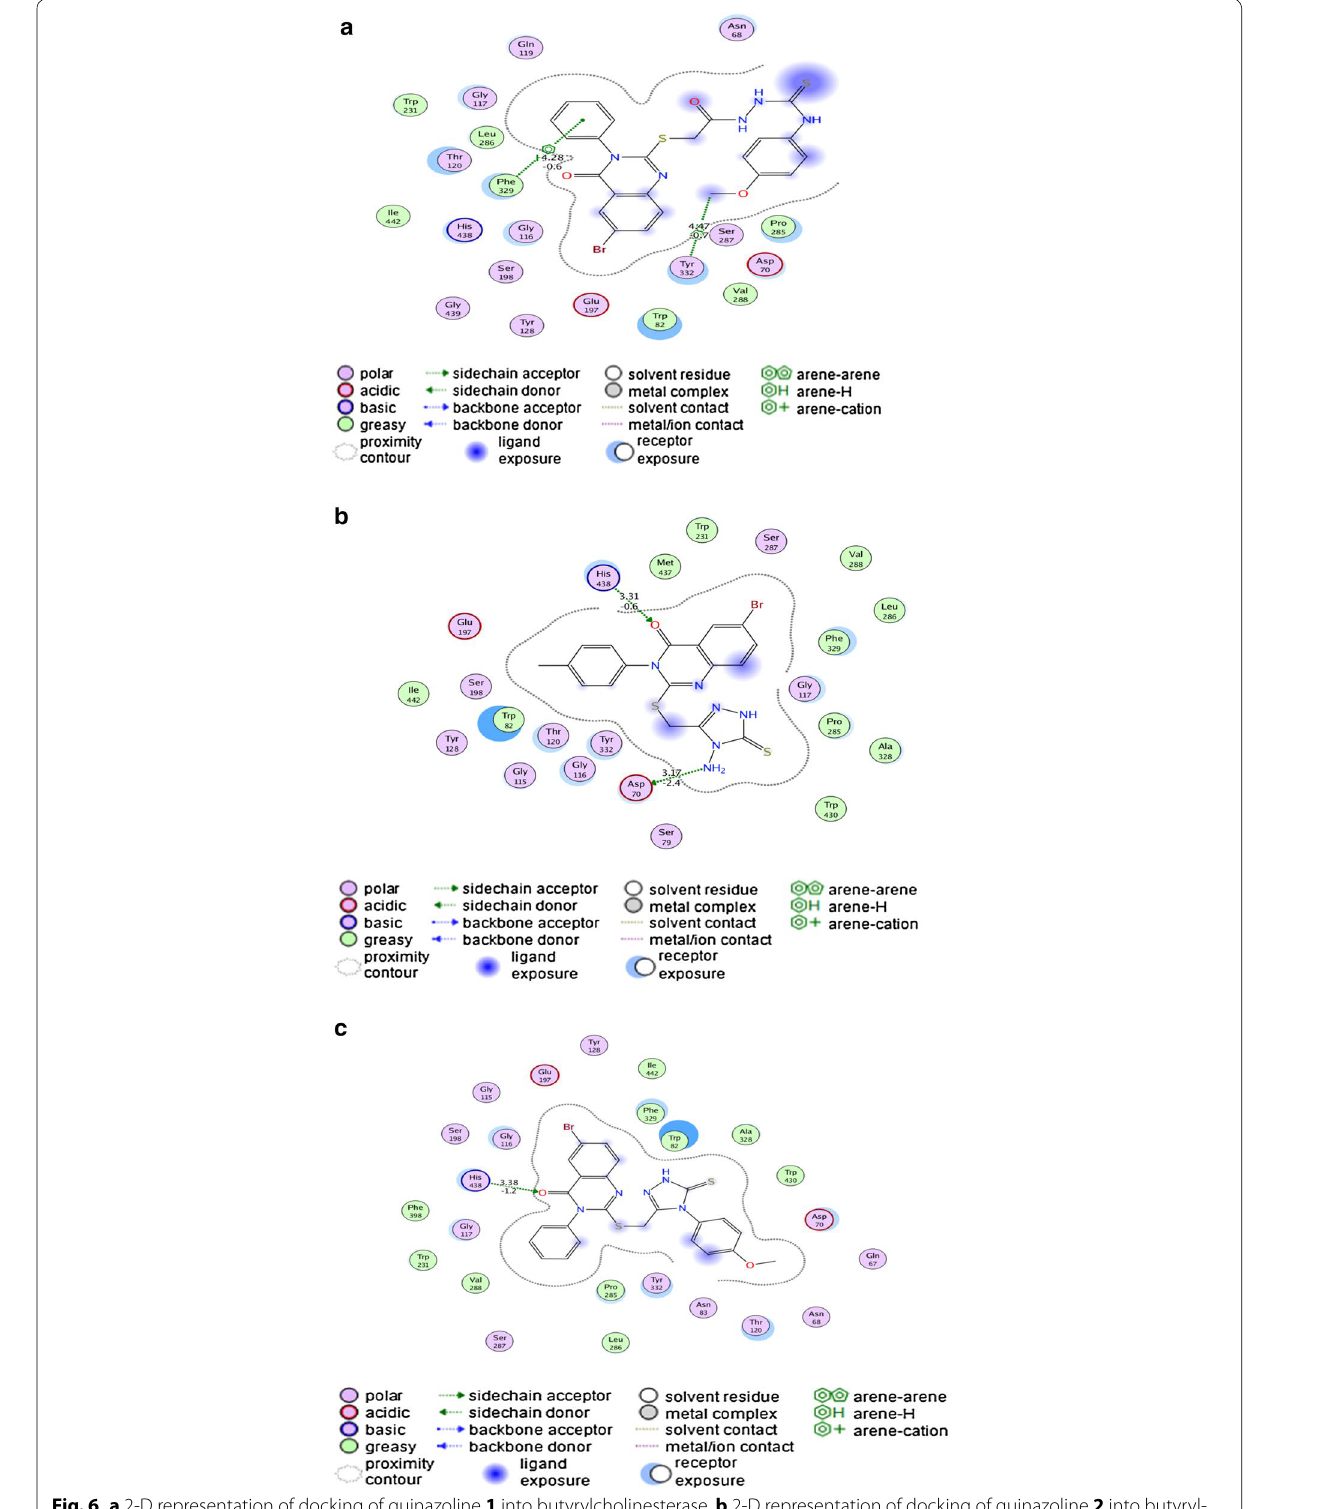
Fig. 6 a 2‑D representation of docking of quinazoline 1 into butyrylcholinesterase. b 2‑D representation of docking of quinazoline 2 into butyryl‑ cholinesterase. c 2‑D representation of docking of quinazoline 3 with